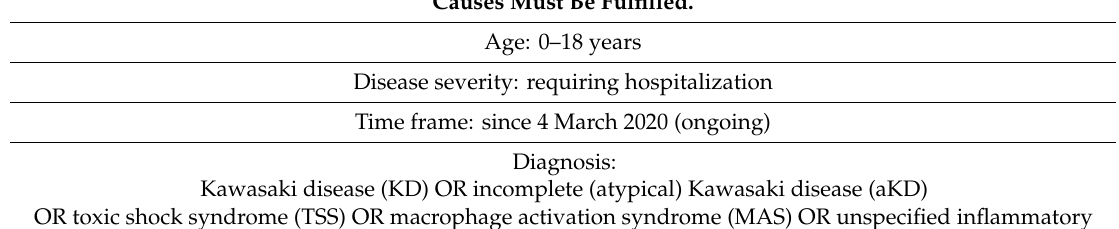
Table 1. Polish register of pediatric inflammatory syndromes (MOIS CoR Study): inclusion criteria. Study Inclusion Criteria: Age, Disease Severity, Timing, Diagnosis Criterion and Exclusion of Other Causes Must Be